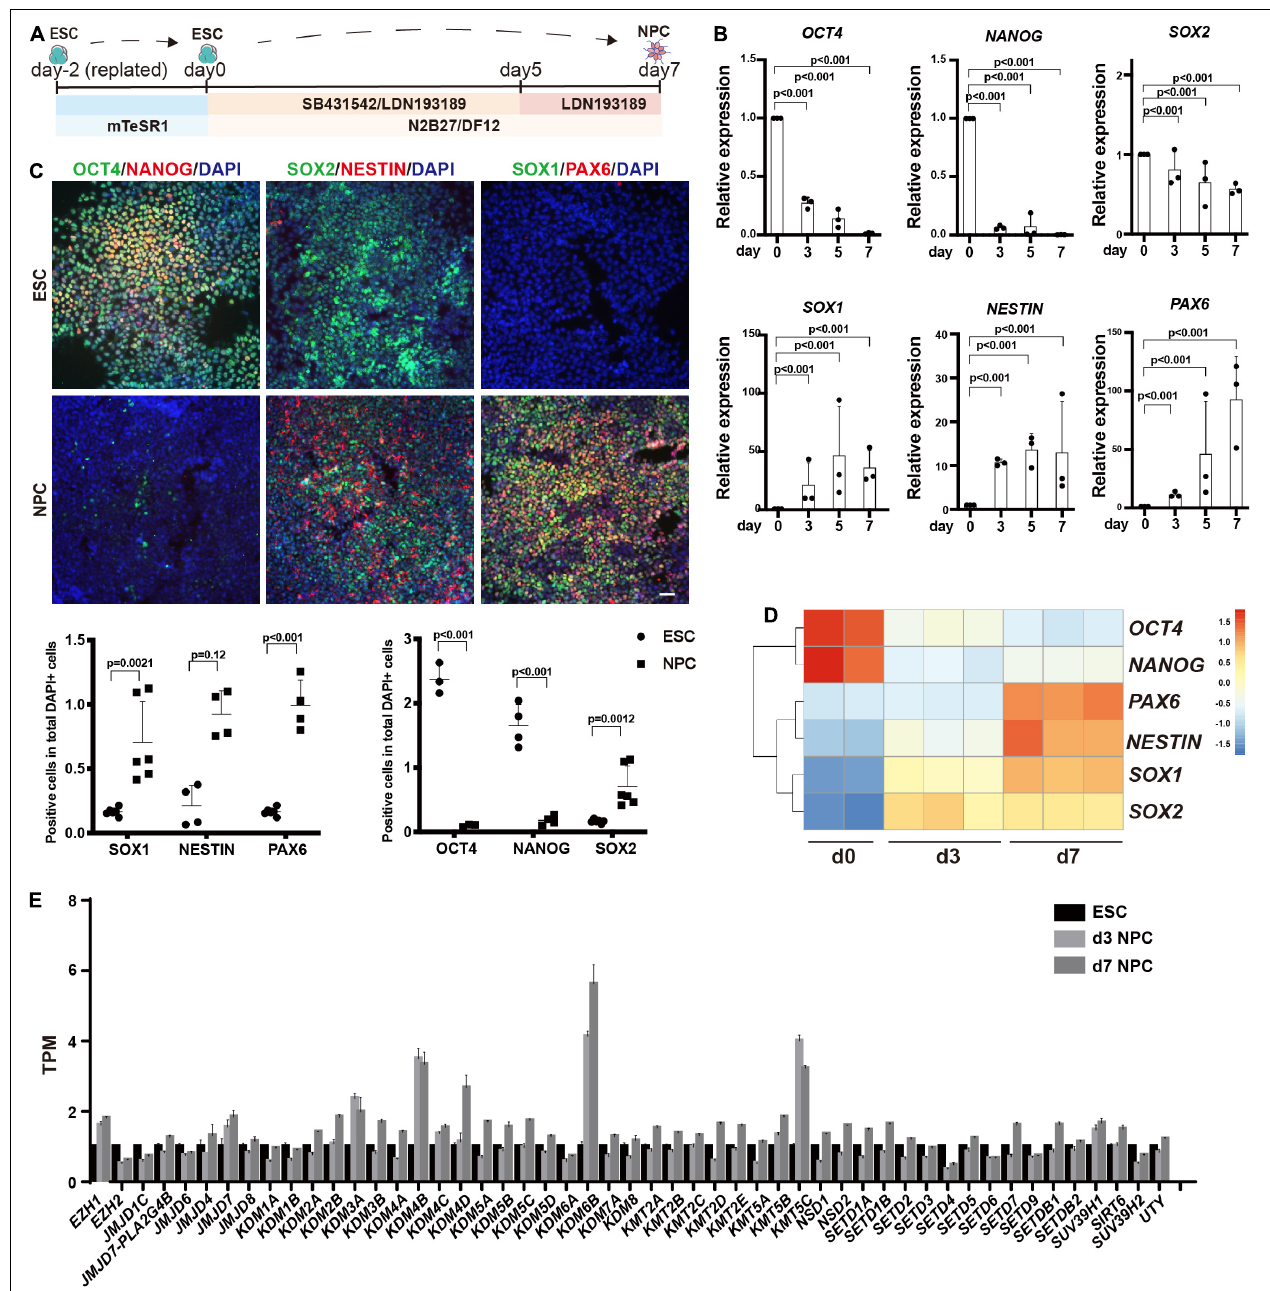
FIGURE 1 | Profiling of histone methylation modifiers during human neuroectoderm differentiation. (A) Scheme for in vitro neuroectoderm differentiation. (B,C) RT-qPCR analysis (B) and immunofluorescence staining (C) of expression dynamics of the pluripotent or neural markers during neuroectoderm differentiation. Representative images and data statistics were shown. Day 0 means undifferentiated ESCs, and day 7 means differentiated neuroectoderm cells. Scale bar = 50 µ m. (D) Heatmap of representative markers by RNA sequencing. (E) The dynamic expression patterns of histone methylation related enzymes during neuroectoderm differentiation by RNA